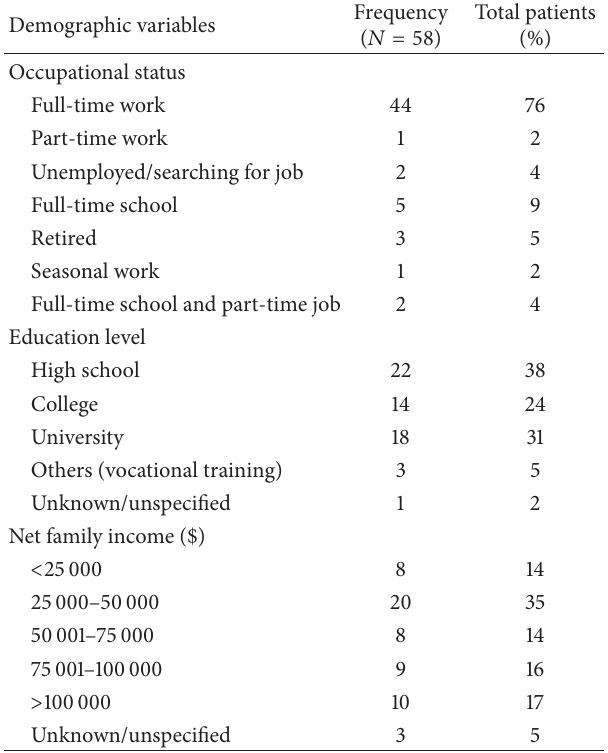
Table 1: Study population